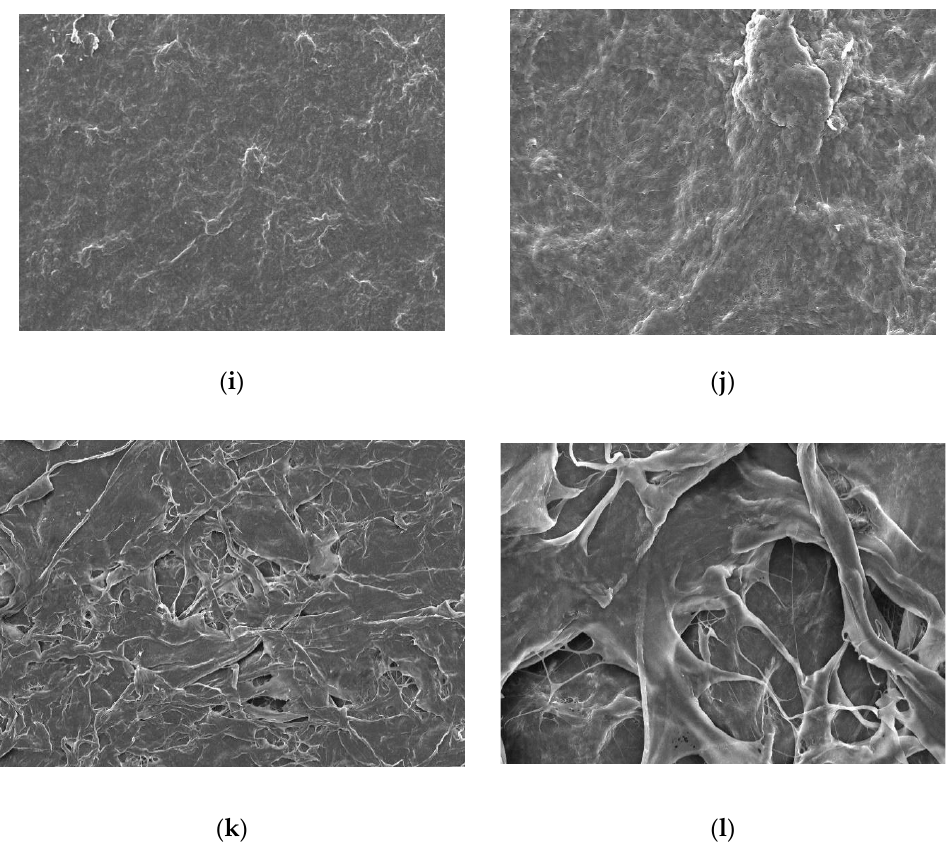
Figure 3. Scanning electron microscope photos: upper surface of Jason membrane at 100X ( a ) and 500X ( b ), base of Jason membrane at 100X ( c ) and 500X ( d ), upper surface of collagen membrane at 100X ( e ) and 500X ( f ), base of collagen membrane at 100X ( g ) and 500X ( h ), upper surface of BioMend Extend membrane at 100X ( i ) and 500X ( j ), base of BioMend Extend membrane at 100X ( k ) and 500X ( l ).